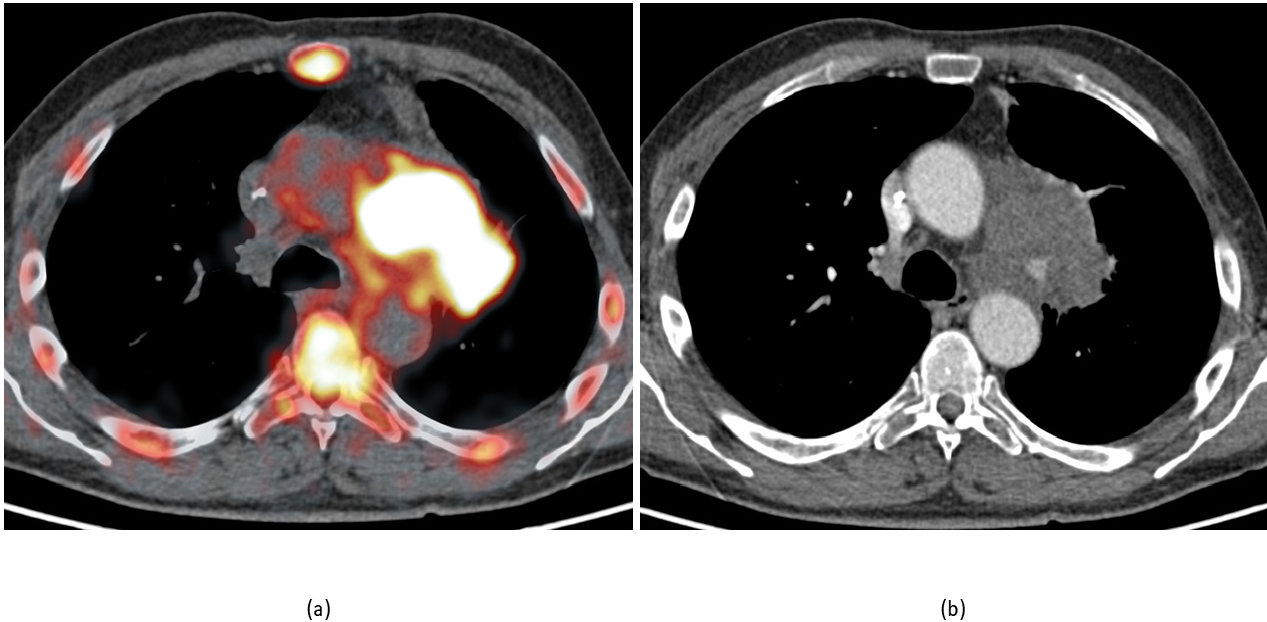
Figure 3. The same patient and study as in Figures 1 and 2. ( a ) Fusion image shows increased uptake in the aortic arch walls and a lung mass infiltrating the mediastinum and forming a close contact with the vessel wall. This makes a direct measurement of the vessel wall’s metabolic activity prone to unintended errors (i.e., part of the tumor tissue may get into a vessel region of interest). ( b ) The arterial phase of the contrast-enhanced CT at the same level shows almost no changes in the aorta walls.